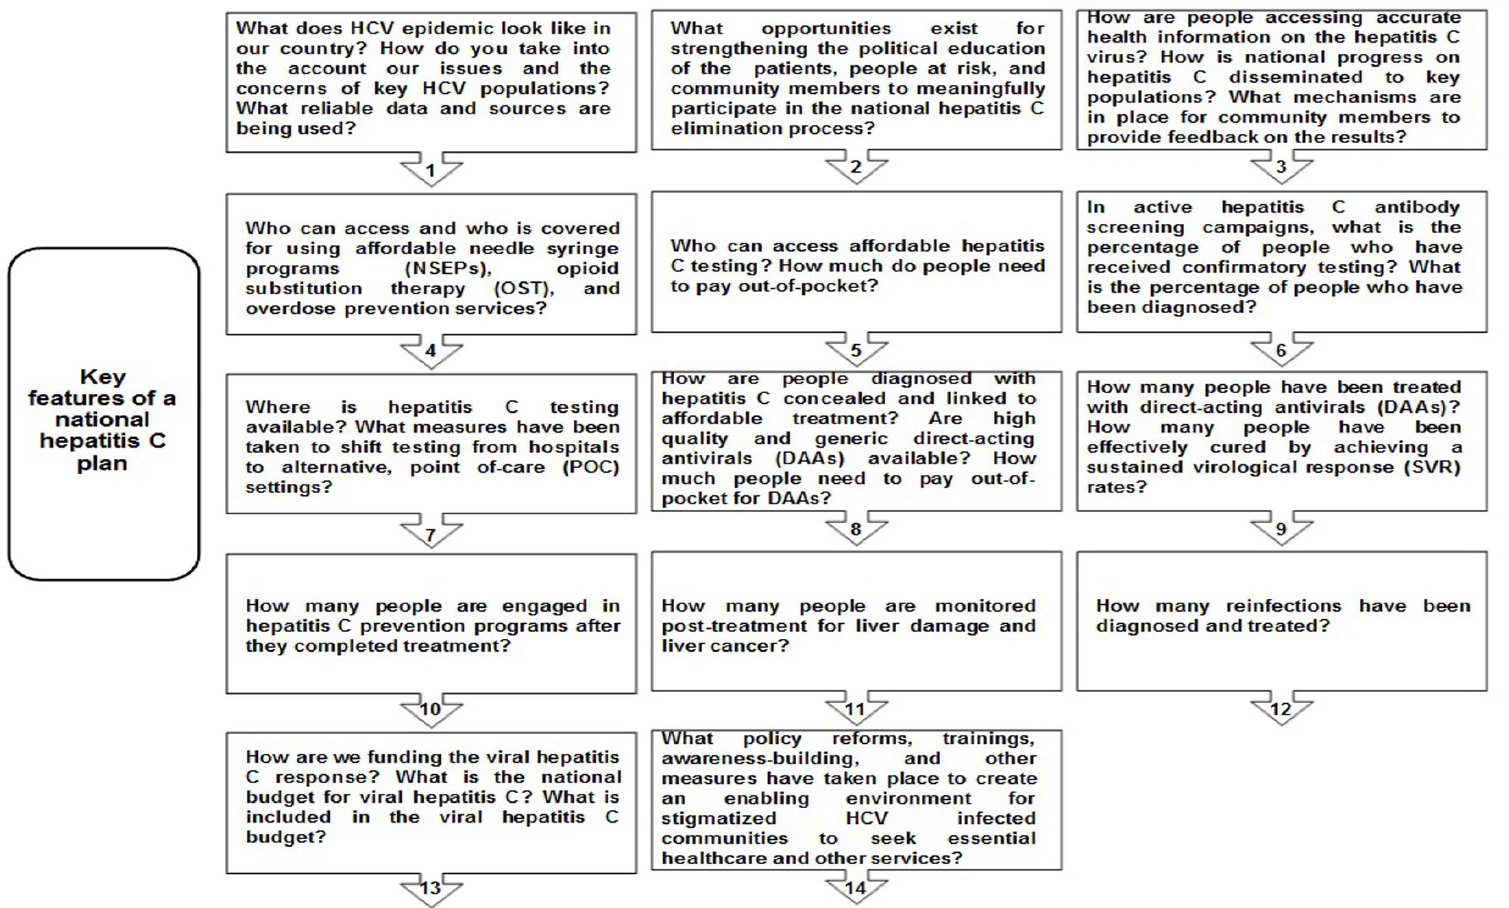
Figure 5. Key features of a national hepatitis C plan at a country level: The WHO member states which are off track or away to achieve the elimination goals of hepatitis C by 2030 should revise and restructure their national hepatitis C plan and reframe their national strategies to scale up HCV diagnosis, facilitating linkage to care, and speed up HCV treatment uptake. The advocacy points outlined in this figure cover all aspects of a national hepatitis C plan or strategy to overcome the barriers in terms of policy implementation and progress monitoring toward elimination goals of hepatitis C by 2030. (Source; Activist Guide to Hepatitis C Virus Diagnostics; Available online: https://www.hepcoalition.org/advocate/advocacy-tools/article/activist-guide-to-hepatitis-c-virus-diagnostics; accessed on 2 April 2021).